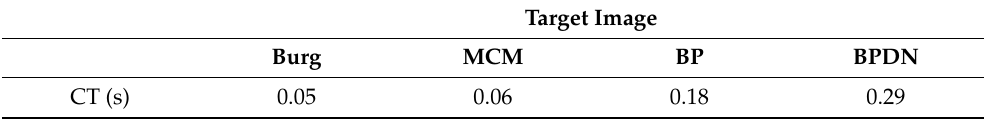
Table 5. CTs for super-resolved target images of extended static target.